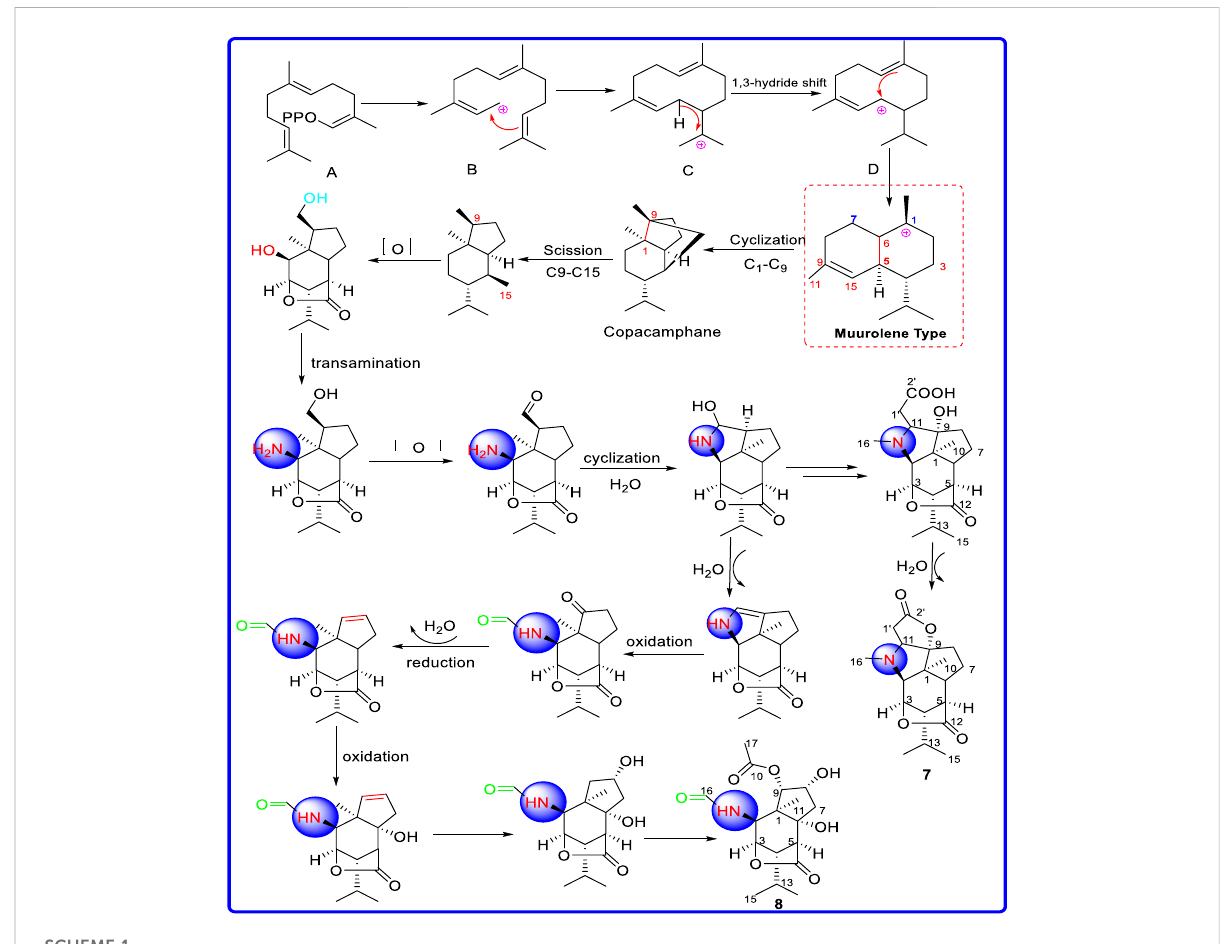
Figure S37 in Supplementary Material) correlations of H-2 with H 3 -11, H-13, of H-3 with H 3 -15, H-13, and of H-5 with